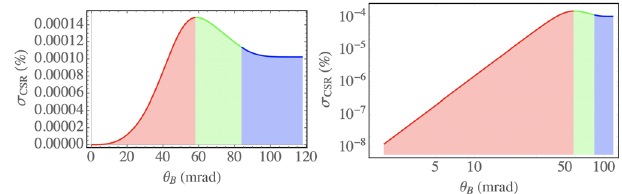
FIG. 1. The CSR rms induced energy spread using numerical integration from the two transient terms in Eq. (1) for various bend angles of a 100 pC, 1.8 GeV electron beam ( σ z ¼ 100 μ m) traversing a bending magnet ( ρ ¼ 10 m). The plots are divided into three regions. Red region: The small angle region where both wakes are present and beginning to separate. Green region: The preceding drift transient, ∝ z A , has slipped past the beam and only the bend transient, ∝ z B , is present. Blue region: The bend transient slips past the beam and the CSR interaction is in steady state. The right plot is a Log-Log plot of the energy CSR rms energy spread and shows the different slopes of the three